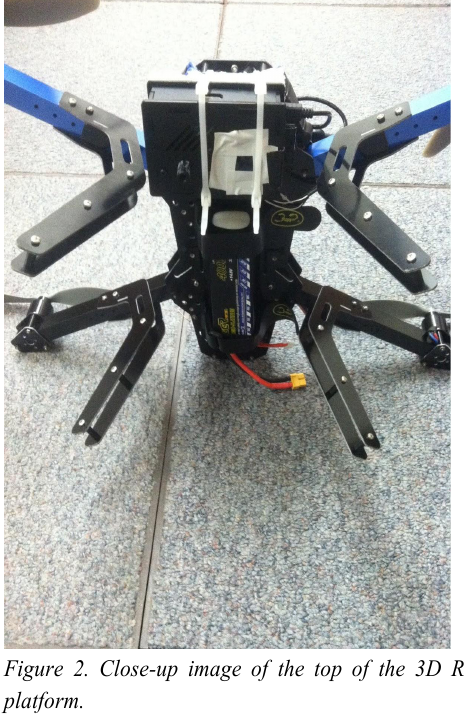
Figure 1. Close-up image of the underside of the 3D Robotics Quad platform